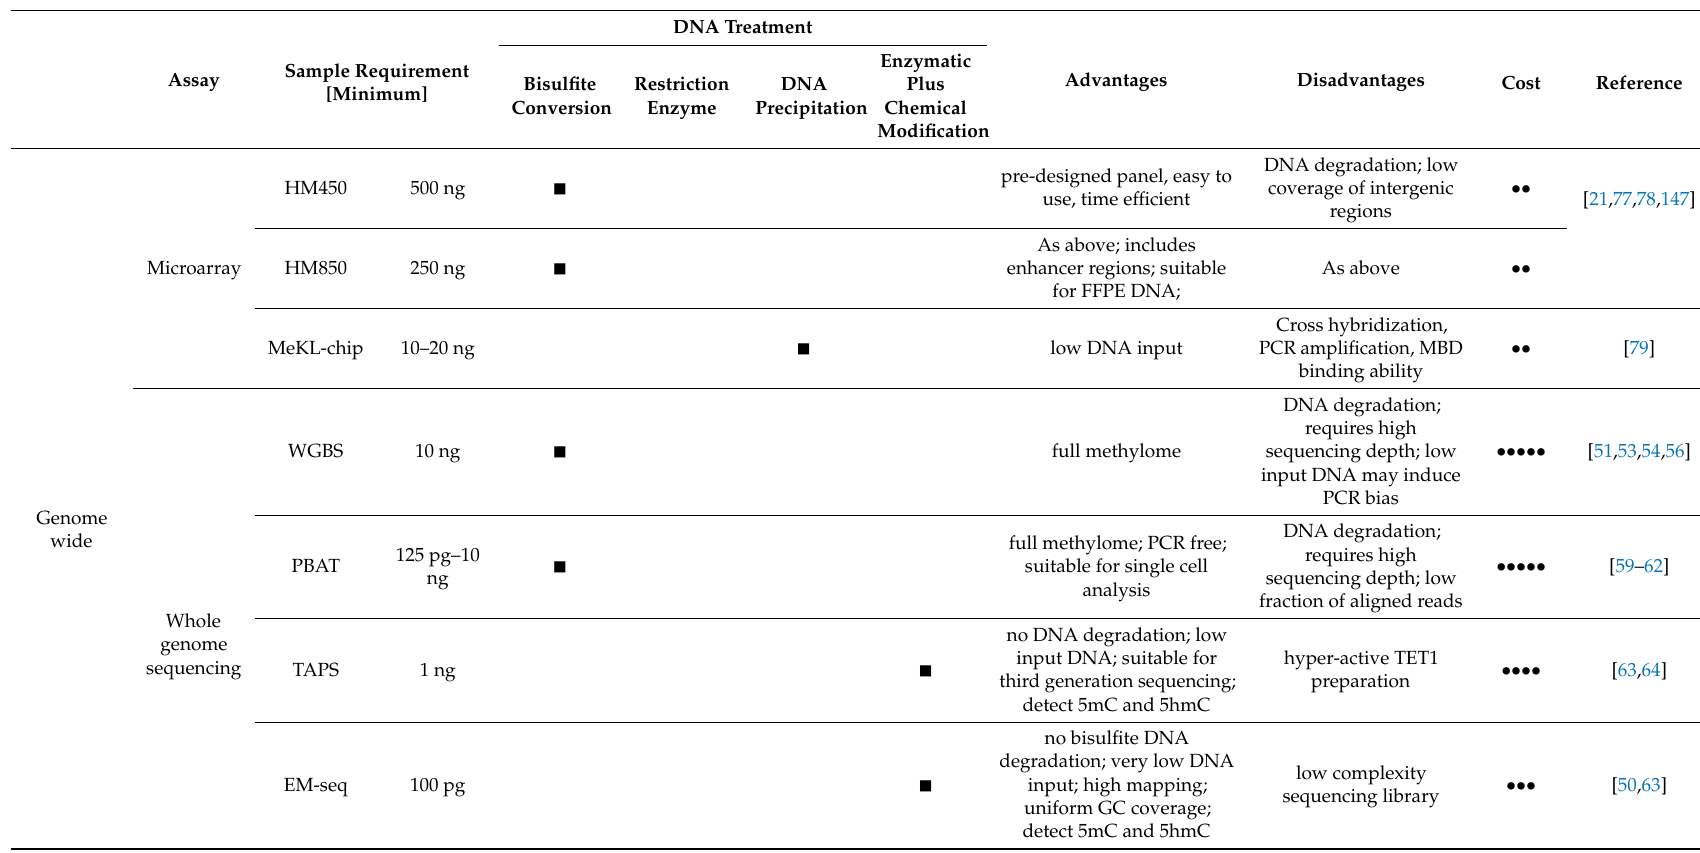
Table 2. Characteristics of the experimental assays suitable for the analysis of DNA methylation in cell-free DNA samples, including sample requirement, DNA treatment protocols, summary of advantages and disadvantages of the assays, cost and references to relevant